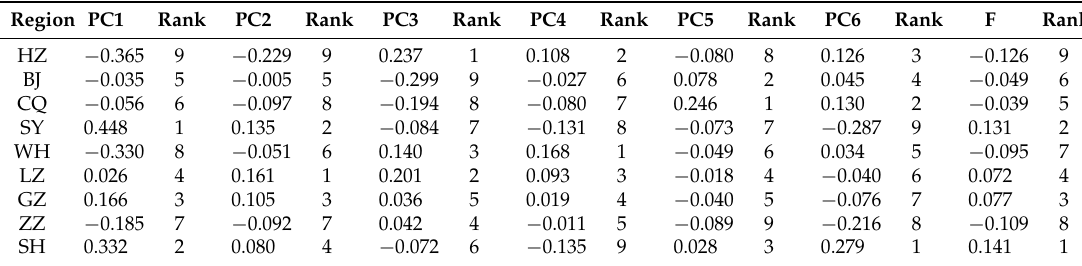
Table 7. Principle component scores of different